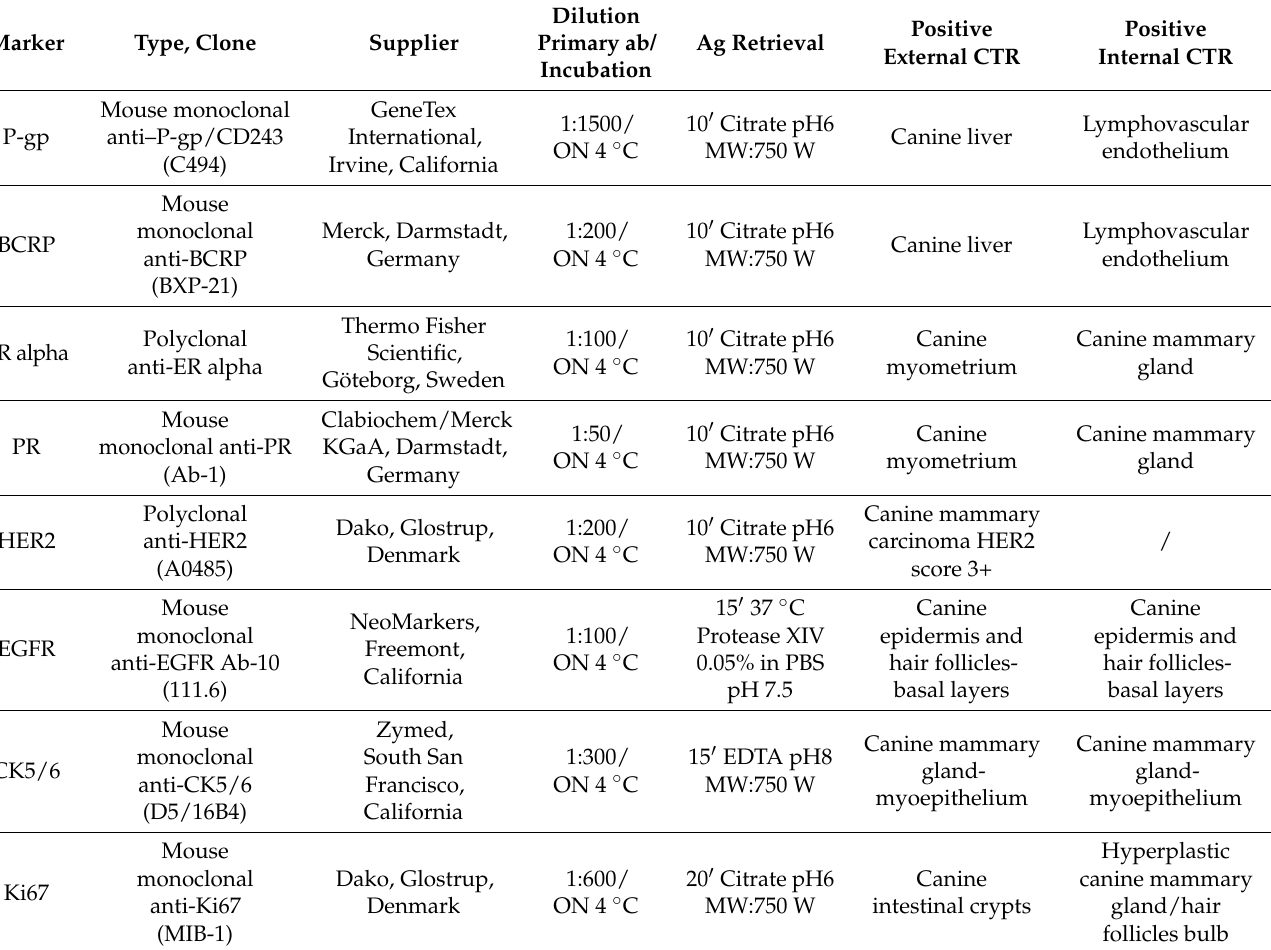
Table 1. Information about Immunohistochemistry (IHC)